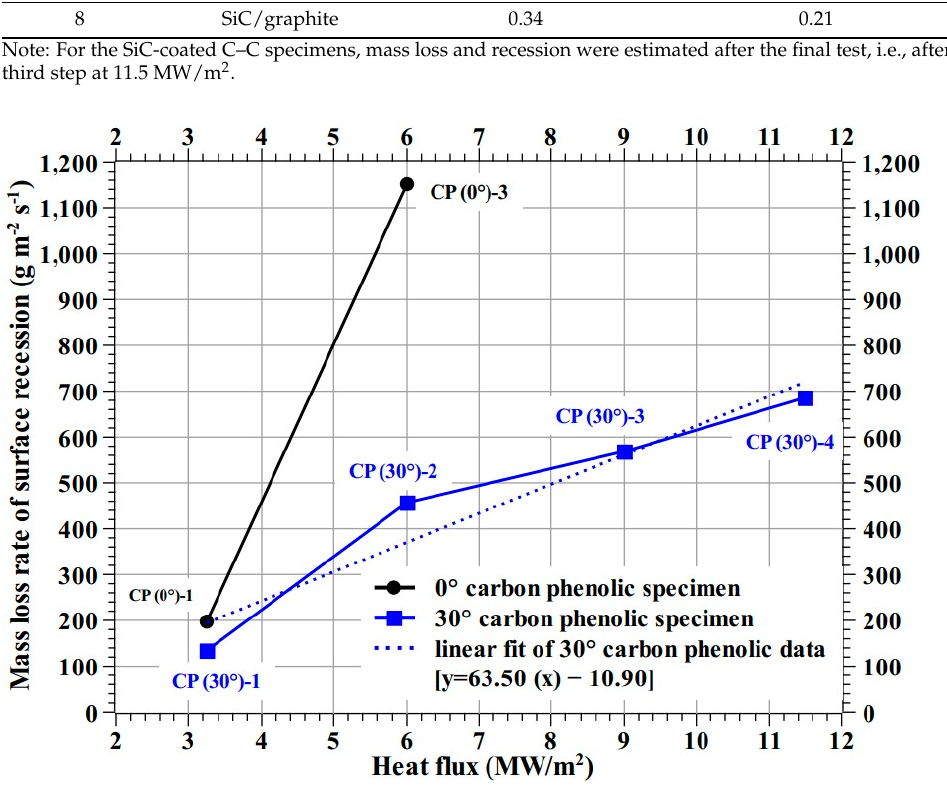
Figure 28. Mass loss rate of surface recession (carbon phenolic).